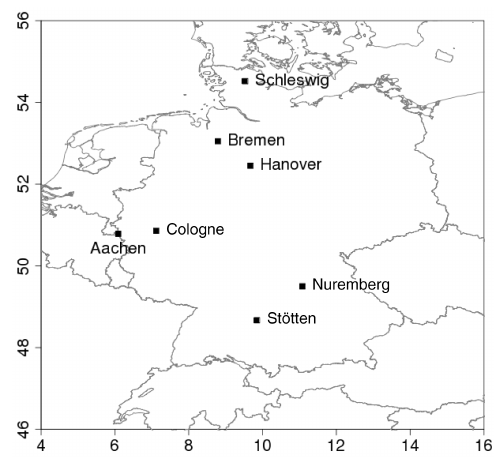
Figure 2. The location of the seven DWD weather stations in the DE-DWD-60 data